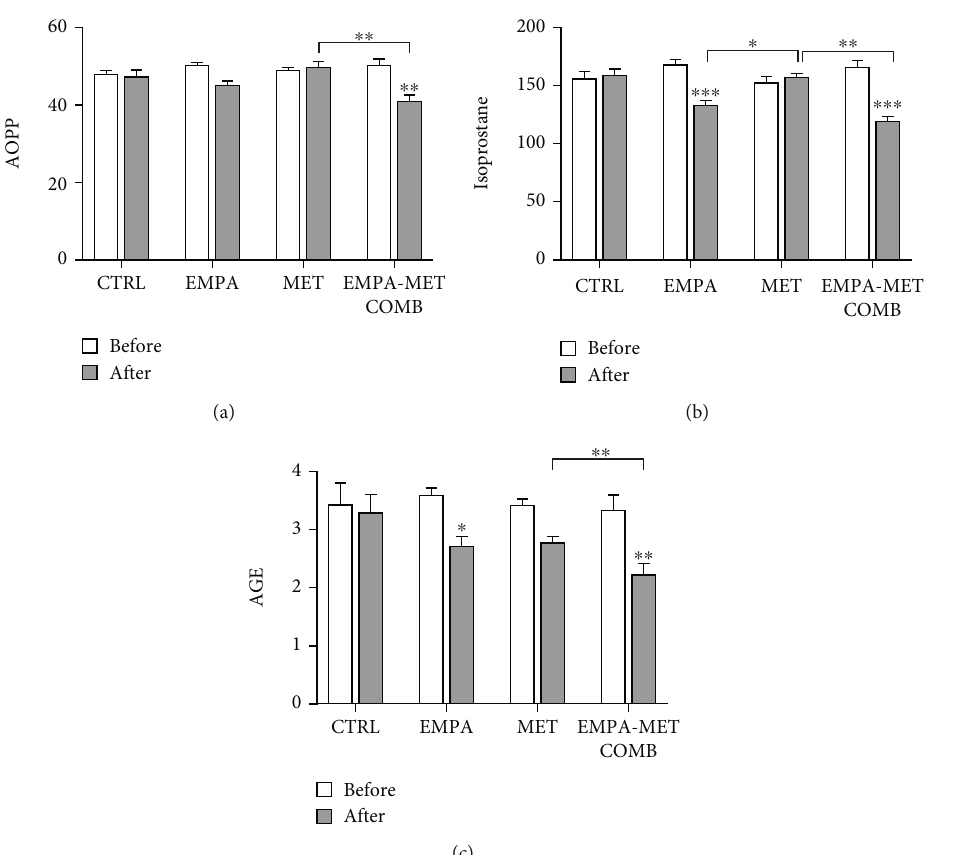
Figure 2: Levels of serum prooxidants in individuals with type 1 diabetes, before and after treatment with empagli fl ozin 25 mg daily (EMPA), metformin 2000mg daily (MET), empagli fl ozin-metformin combination (EMPA-MET COMB), or in control (CTRL) groups: (a) advanced oxidation protein products (AOPP), (b) isoprostane, and (c) advanced glycation end products (AGE). ∗ represents P < 0 : 05 ; ∗∗ represents P < 0 : 01 , and ∗∗∗ represents P < 0 : 001 .